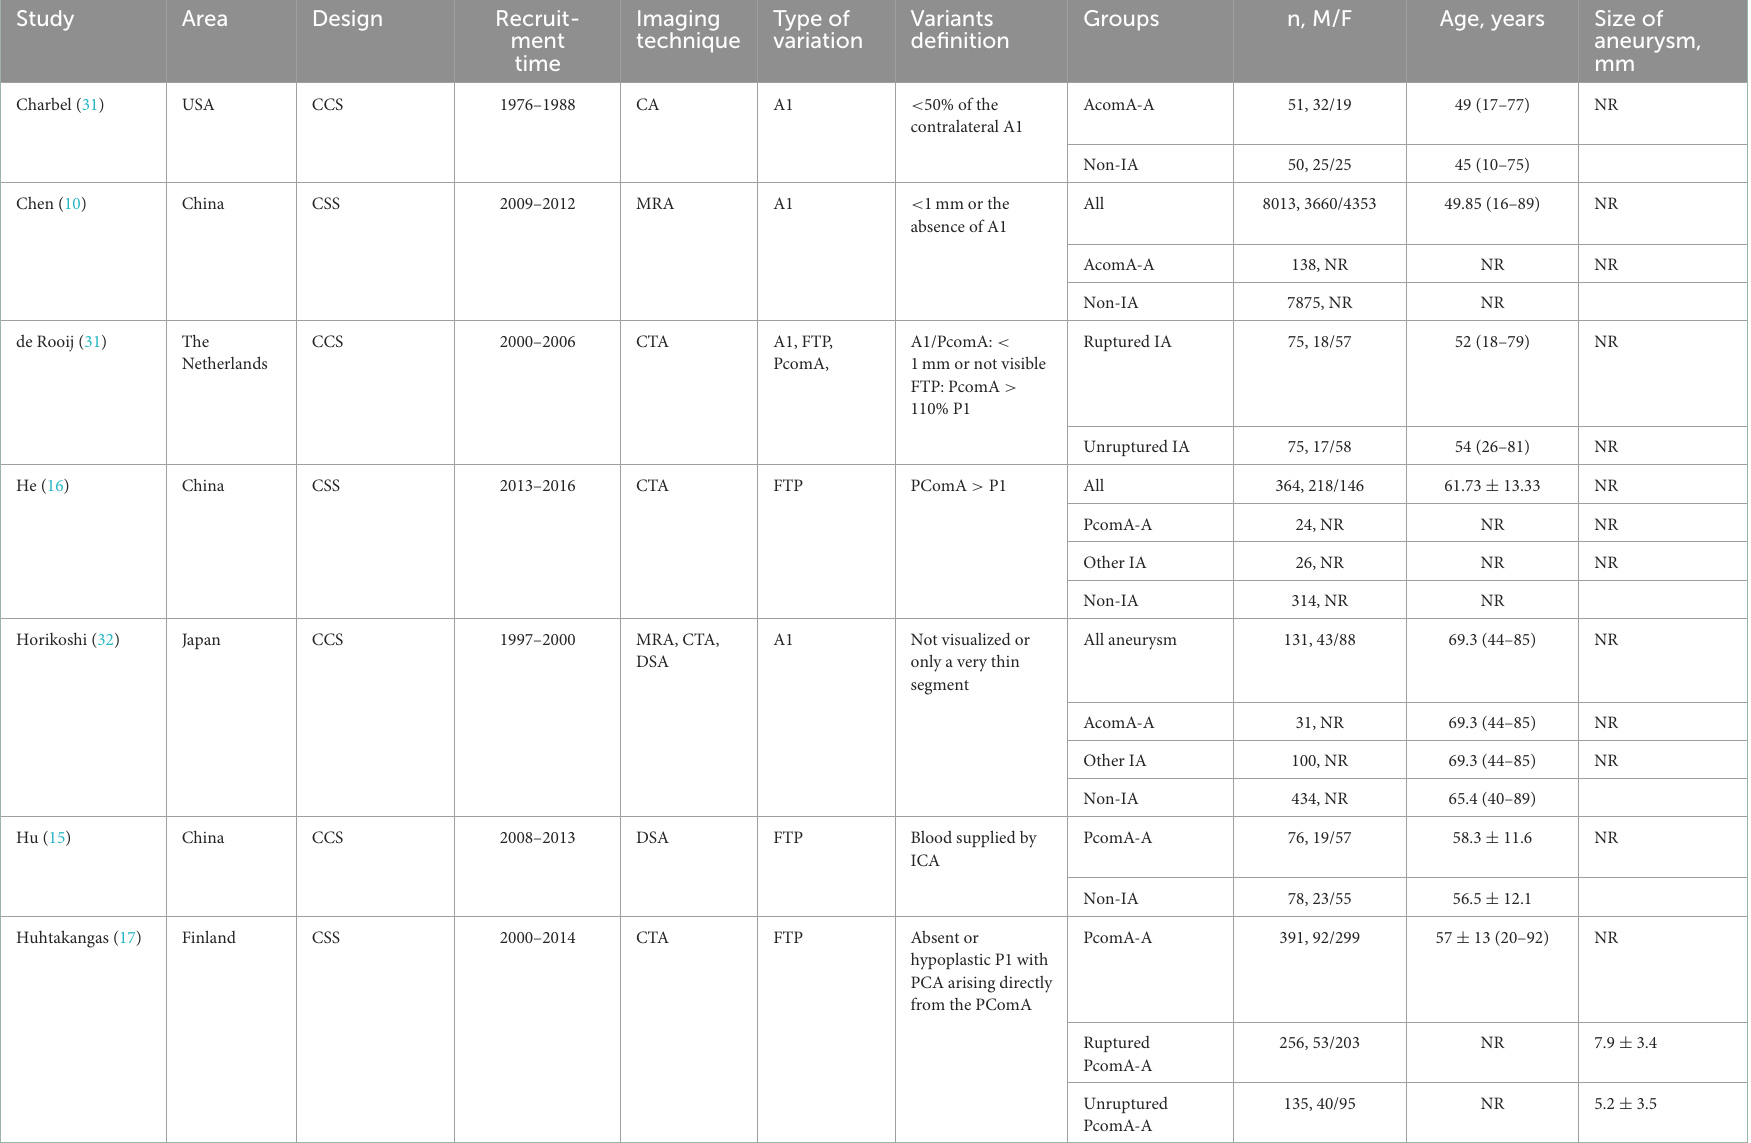
TABLE 1 Characteristics of the included studies in this